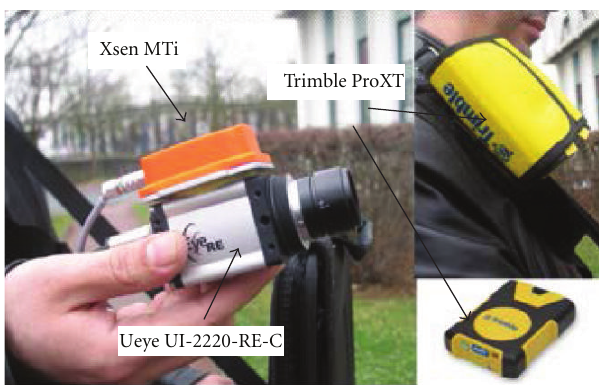
Figure 1: Sensor components of our Hybrid tracker.